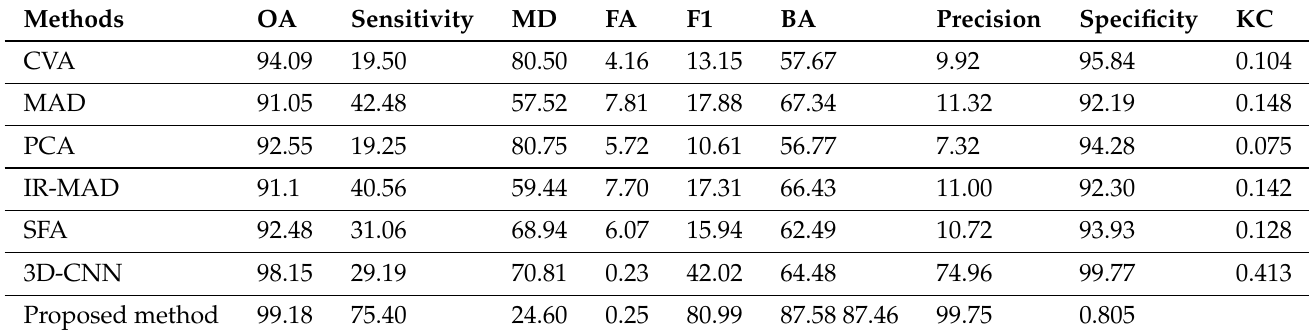
Table 17. Quantitative results for multispectral images [157].